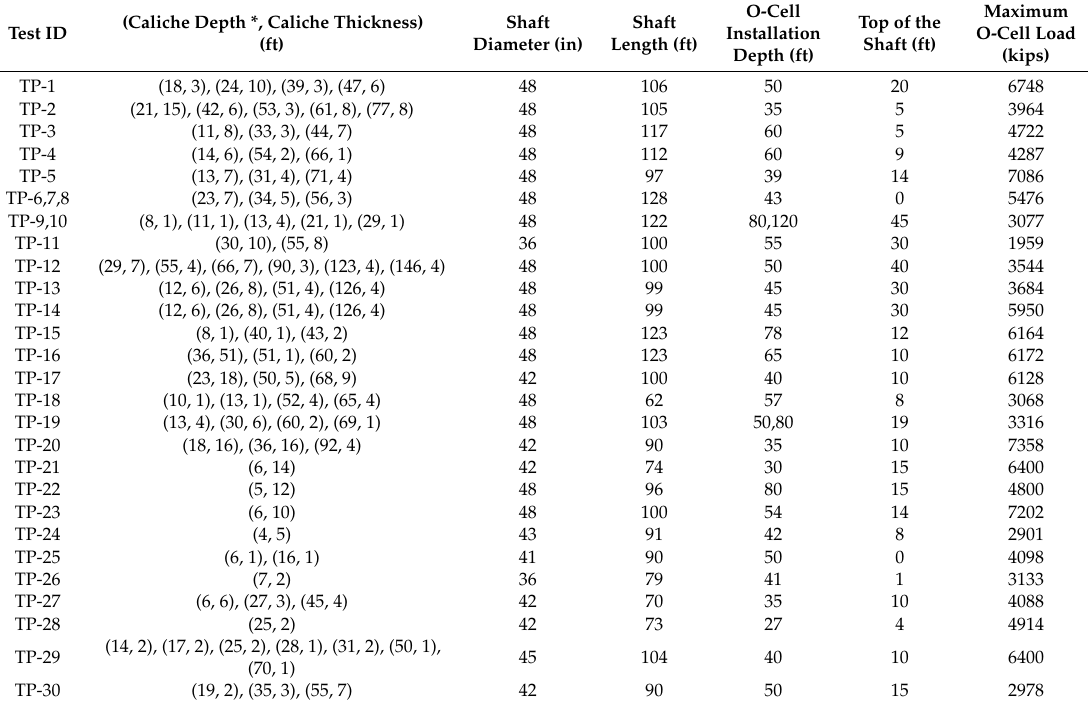
Table 1. Geometries of the drilled shaft, caliche layers and reported bidirectional loads based on 30 Osterberg